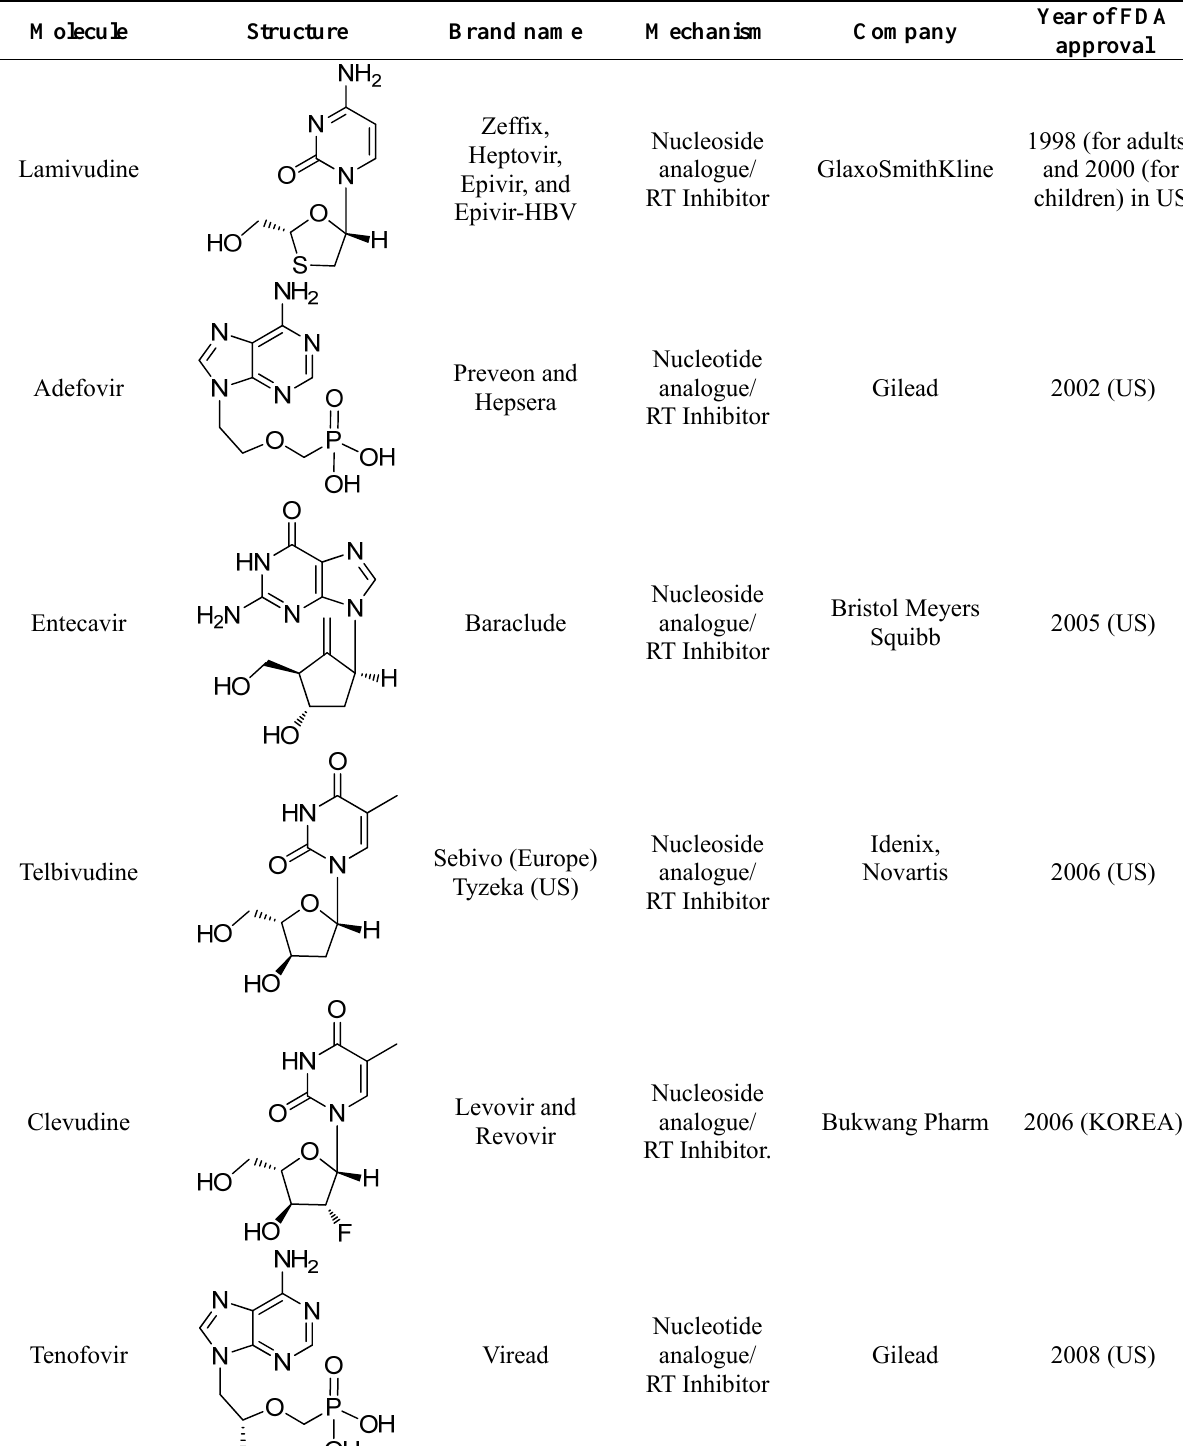
Table 1. Approved anti-HBV